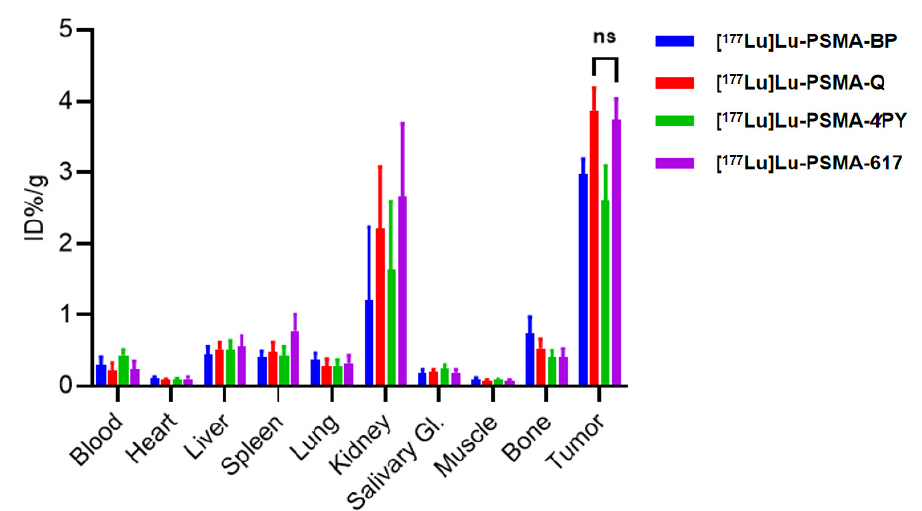
Figure 5. Uptake values for ex vivo tissues of 22Rv1 tumor-bearing mice 24 h p.i. ( n = 3). Due to the high uptake in the tumor and the fast clearance rate, the tumor-to-blood (T/B), tumor-to-muscle (T/M) and tumor-to-kidney ratios were 17.59, 48.38 and 1.75, which were higher than those of [ 177 Lu]Lu-PSMA-617(15.58 for T/B, 46.75 for T/M and 1.40 for T/K), [ 177 Lu]Lu-PSMA-BP (9.61 for T/B, 29.80 for T/M and 1.34 for T/K), and [ 177 Lu]Lu-PSMA-4PY (6.07 for T/B, 29.00 for T/M and 1.59 for T/K).